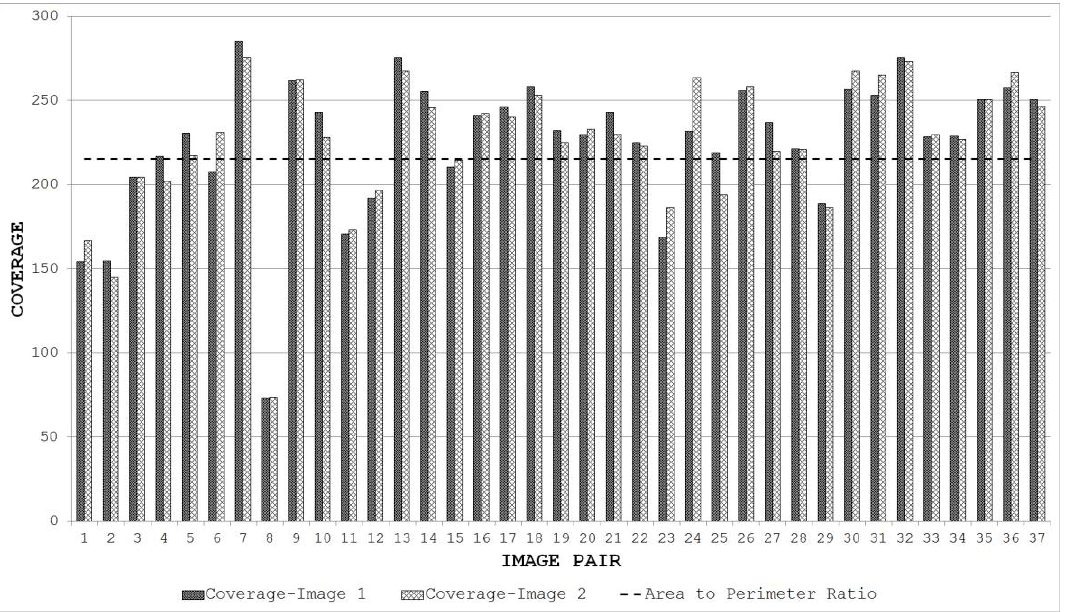
Figure 18. Coverage results of IBR for the database.